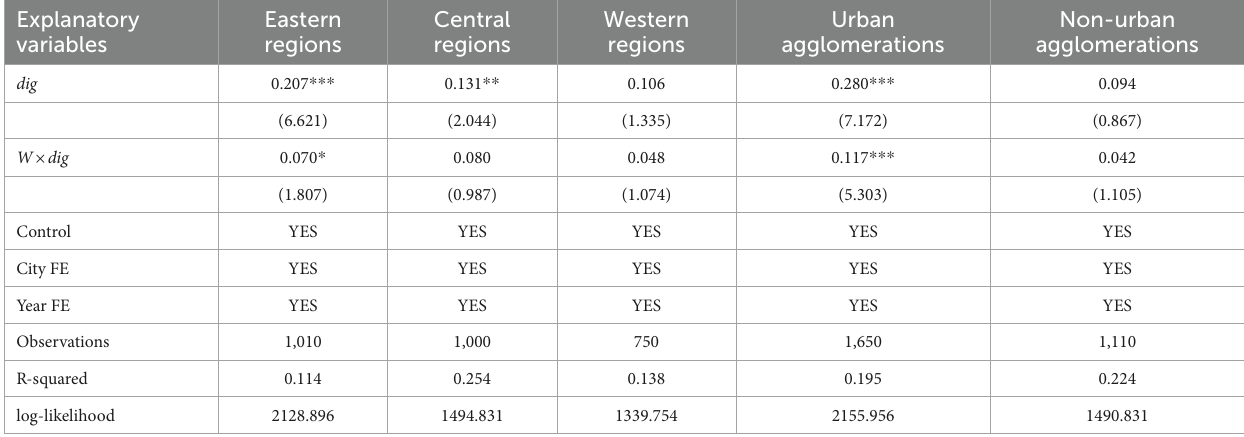
TABLE 10 Regression results of the spatial heterogeneity